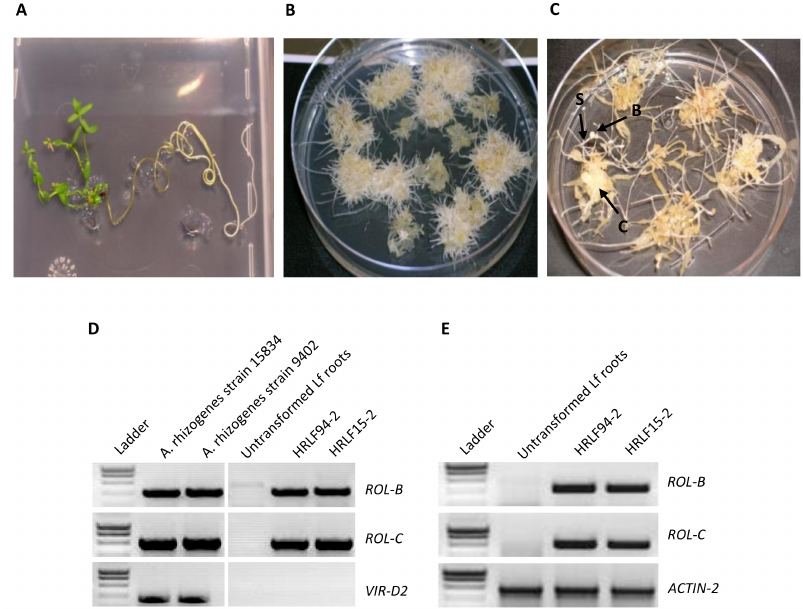
Figure 2. A. rhizogenes -mediated transformation and molecular characterization of the resulting L. flavum HR lines. ( A ) Germination of wild type Linum flavum ; ( B ) Hairy roots of Linum flavum , line HRLF15.2; ( C ) Hairy roots of Linum flavum , line HRLF94-6 (C: callus, B: bud, S: shoot); ( D ) PCR amplified DNA fragments of ROL-B , ROL-C and VIR-D2 pro-oncogenes from the plasmidic DNA of A. rhizogenes strains or genomic DNA of L. flavum . From left to right: Ladder, DNA from the plasmids of A. rhizogenes LBA 9402 and ATCC 15834 strains respectively, used as positive control, genomic DNA of wild type roots L. flavum cultivated in vitro used as negative control, genomic DNA from two transgenic L. flavum hairy roots lines, HRLF94-2 and HRLF15-2 respectively. ( E ) sqRT-PCR analysis of ROL-B and ROL-C pro-oncogene expressions in L. flavum wild type roots and in two transgenic L. flavum hairy roots lines, HRLF94-2 and HRLF15-2 respectively. Total RNAs isolated from hairy roots were subjected to sqRT-PCR analysis using ACTIN-2 gene as internal control. Ten microliters of RT-PCR products were loaded on 1% ( w / v ) agarose